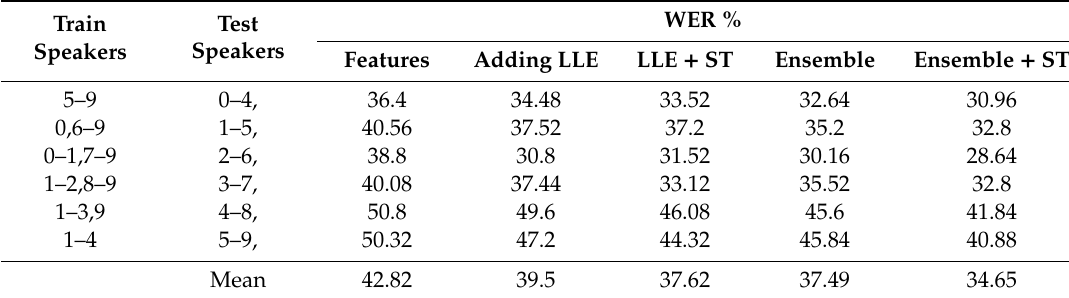
Table 9. Word Error Rate for 50% data as test.